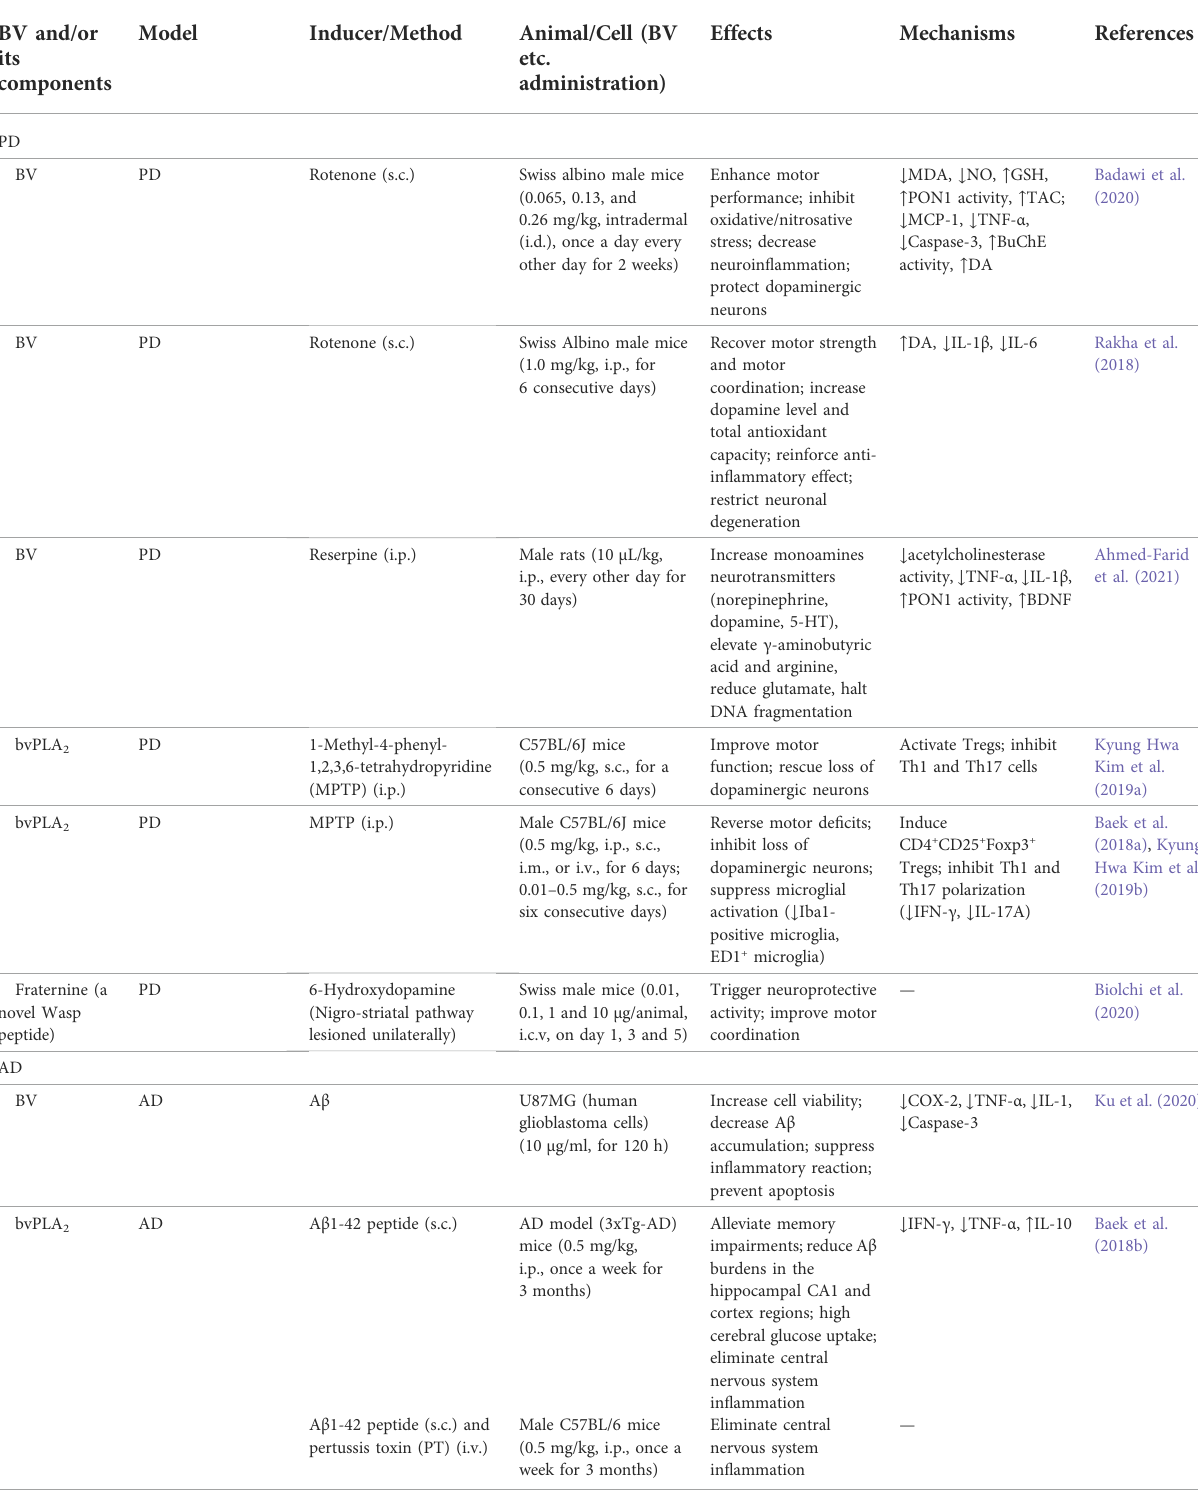
TABLE 2 Summary of the role and mechanism of BV and its main components in treating neurological